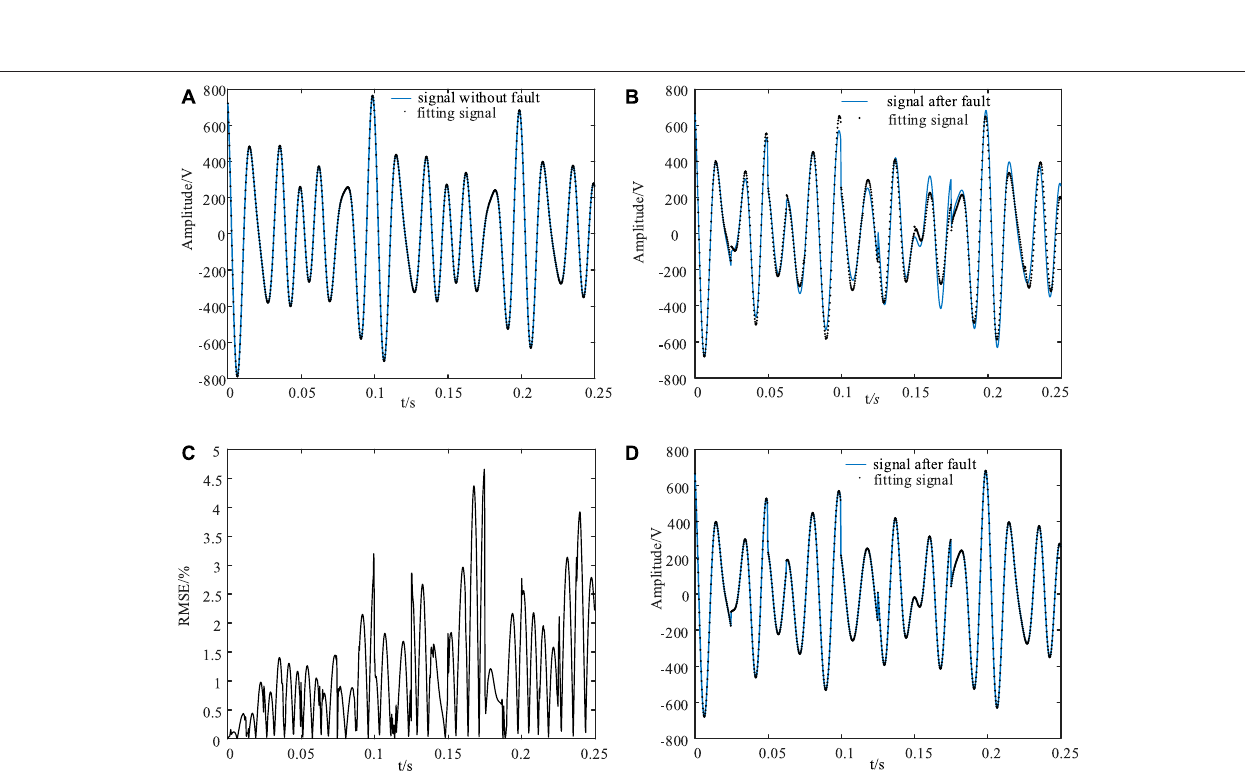
FIGURE 2 | Simulation results: (A) Smooth signal simulation based on the traditional Prony method. (B) Mutation signal simulation based on the traditional Prony method. (C) RMSE of the original and fi tting signals based on the traditional Prony method. (D) Mutation signal simulation based on the proposed method in this article.